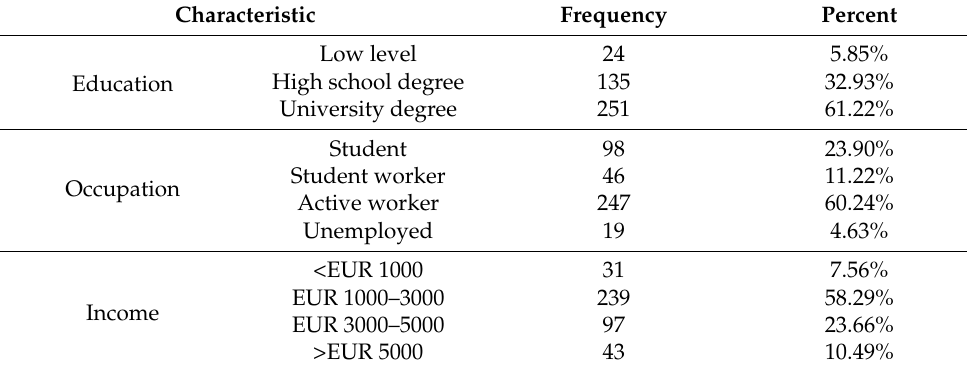
Table 2. Characteristics of participants.